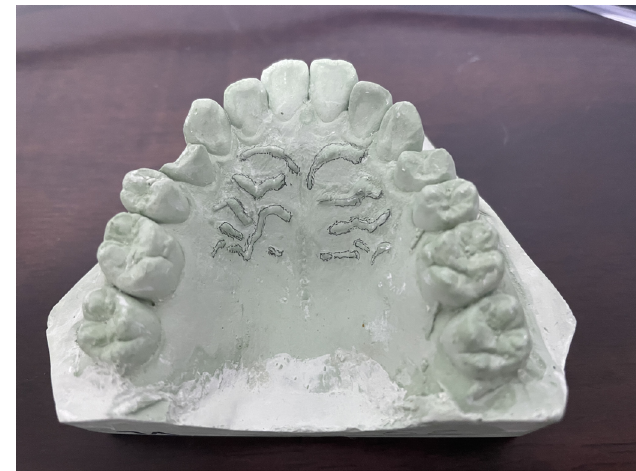
Figure 4. Highlighting the rugae with a pencil on a conventional plaster dental cast